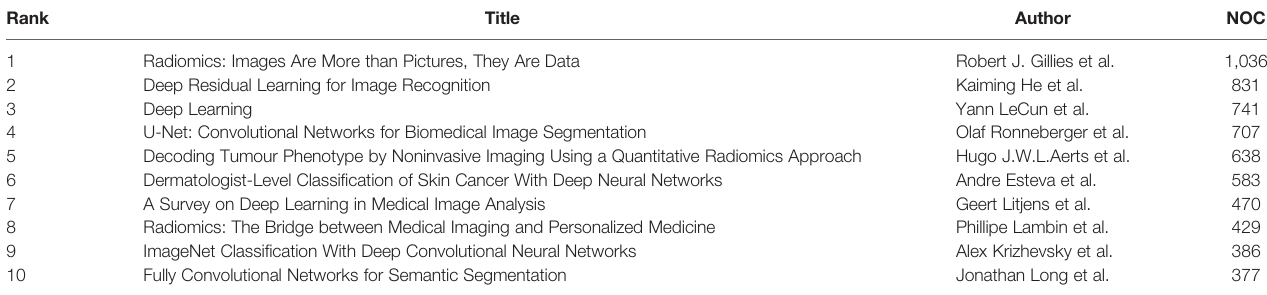
TABLE 1 | The top 10 co-cited